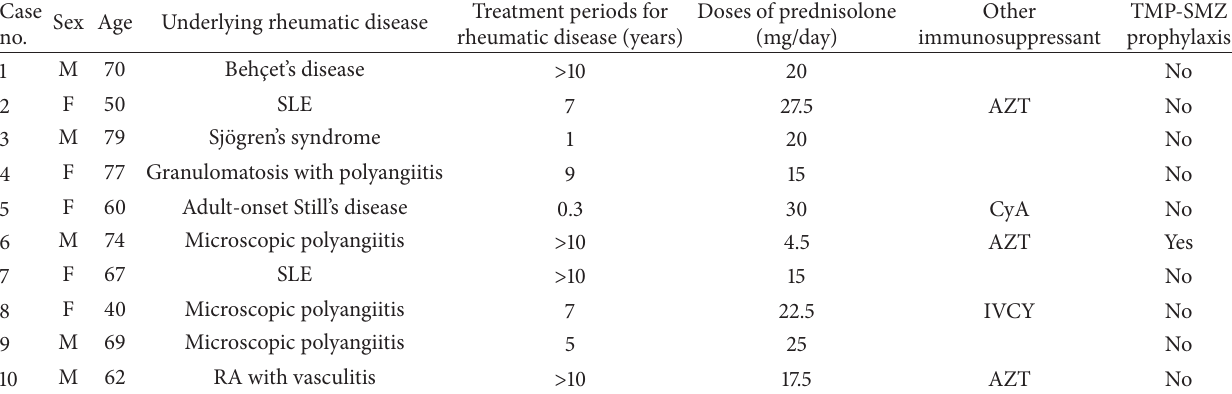
Table 1: Demographics and characteristics of 10 rheumatic disease patients with Nocardia infection.